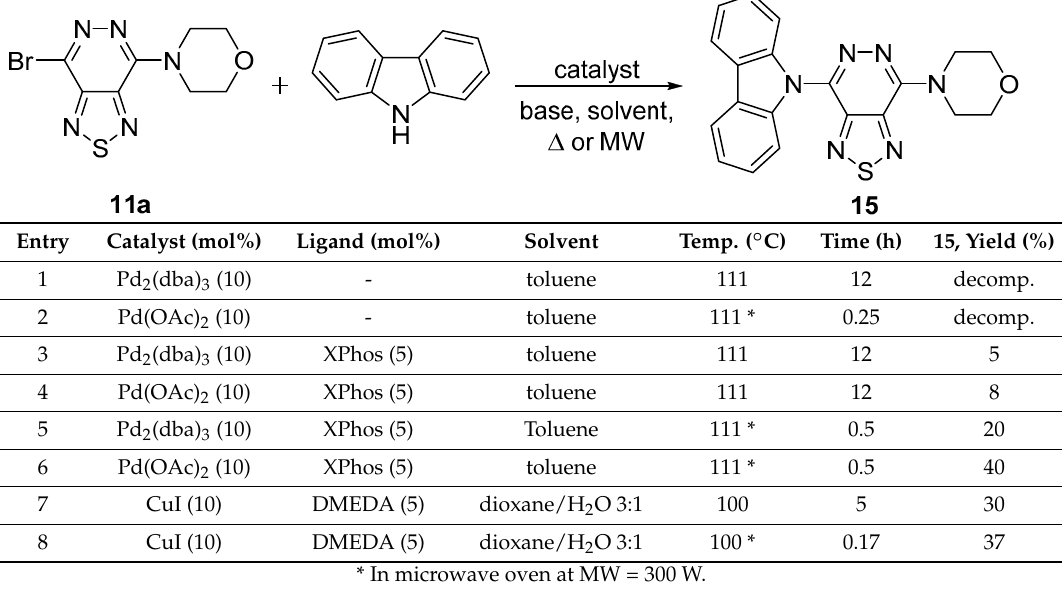
Table 5. Buchwald-Hartwig and Ullmann coupling of 4-(7-bromo[1,2,5]thiadiazolo[3,4- d ]pyridazin- 4-yl)morpholine 11a with carbazole.